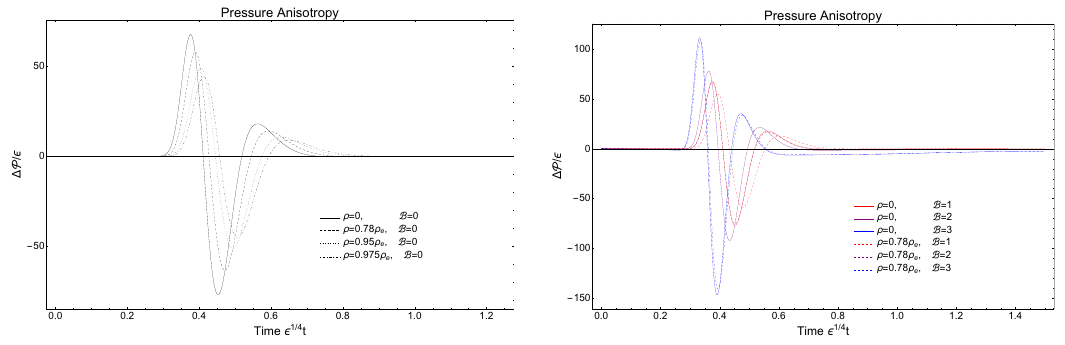
Figure 6 . The pressure anisotropy (cid:1) P = P T (cid:0) P L + 1 case considered in this work displayed